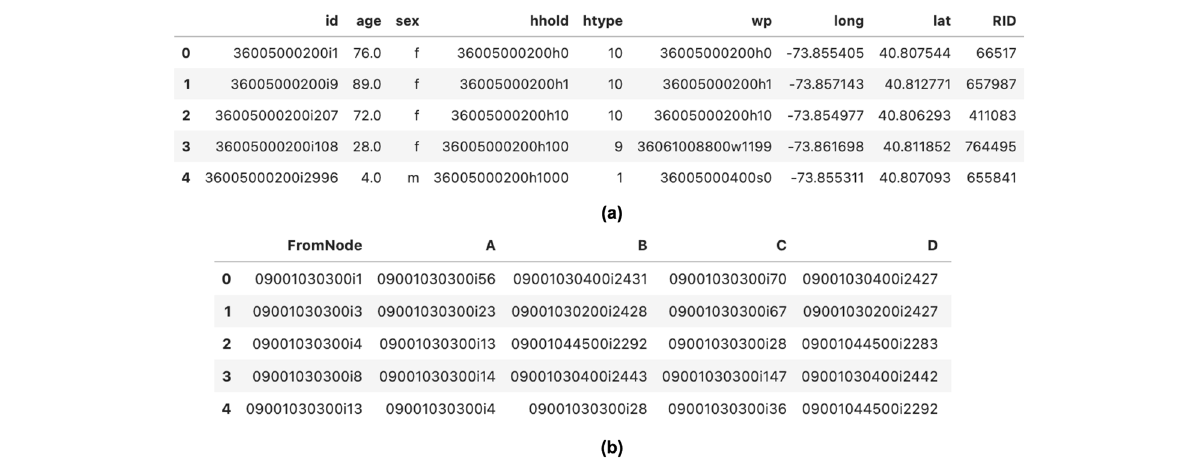
Fig. 5 Sample Records: ( a ) Synthetic Population; ( b ) Synthetic Social